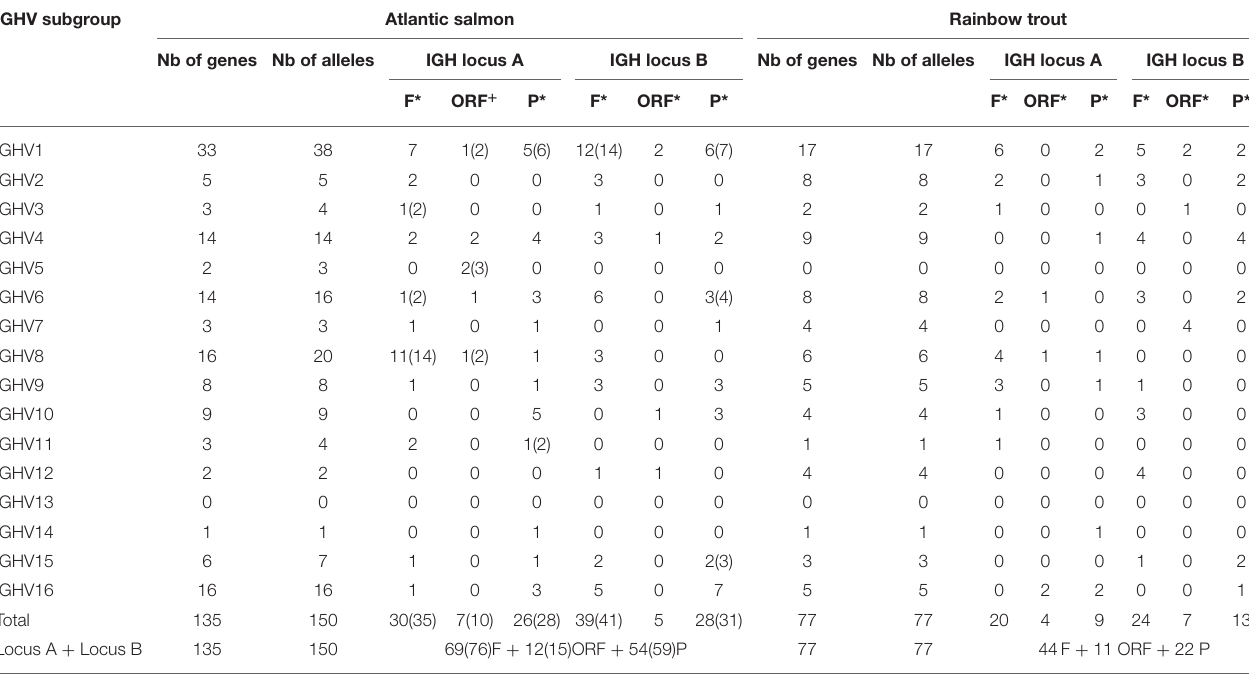
TABLE 5 | Atlantic salmon ( S. salar ) and rainbow trout ( O. mykiss ) IGHV alleles included in the IMGT/V-QUEST reference directory sets (release 201931-4, 1st August 2019). IGHV